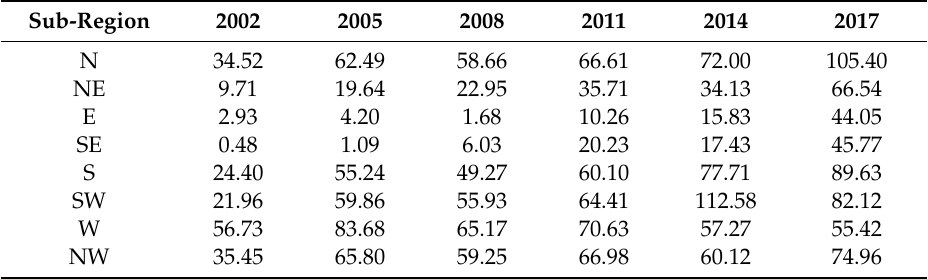
Table 10. The impervious surfaces contribution indexes (ISCIs) in the eight sub-region.